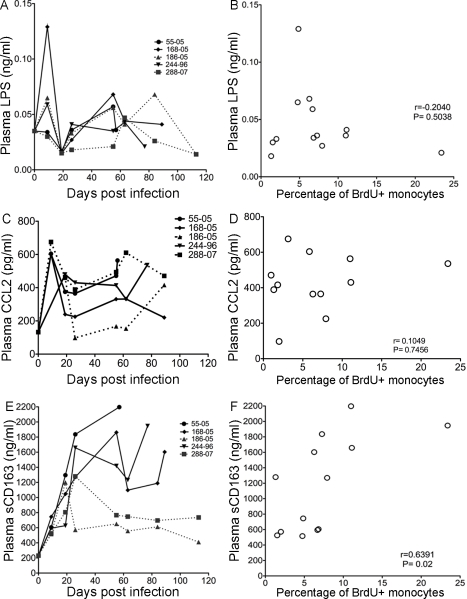
sCD163 levels in plasma, but not LPS or CCL2, correlates with percentage of BrdU+ in total monocytes.
A. LPS plasma levels in the individual SIV infected animals after infection are shown. Solid lines are plasma LPS levels in rapid progressors. Dashed lines are plasma LPS levels in slow progressors. B. There is no correlation between plasma LPS levels with the percentage of BrdU+ monocytes. C. CCL2/MCP-1 plasma levels in individual SIV infected animals after infection are shown. The solid lines represent plasma CCL2/MCP-1 levels in rapid progressors. The dashed lines represent plasma CCL2/MCP-1 levels in slow progressors. D. There is no correlation between plasma CCL2/MCP-1 and the percentage of BrdU+ monocytes. E. sCD163 plasma levels in individual SIV infected animals after infection are shown. Solid lines are sCD163 plasma in rapid progressors. Dashed lines are sCD163 plasma in slow progressors. F. There is a significant correlation between sCD163 plasma levels and percentage of BrdU+ monocytes. The Spearman rank test is used.